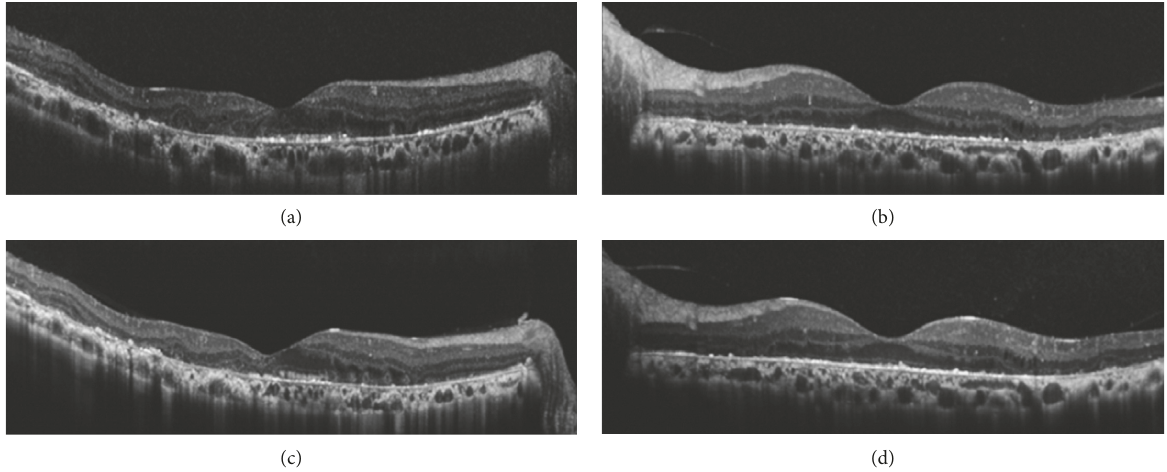
Figure 5: Comparison of first and last SD-OCTimages from patients with type 1 and type 2 BCD. (a) and (c): First and last SD-OCTimages, respectively, of the right eye of type 1 patient P2, showing thinning of retina and choroid in macula area and shortening of EZ in fovea. (b) and (d): First and last SD-OCT images, respectively, of the left eye of type 2 patient P4, showing no significant changes in macula